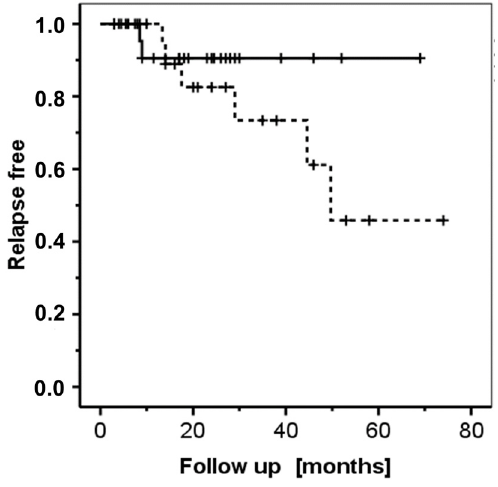
Figure 5. Relapse-free survival as a function of follow-up time (in months). Solid line: Gliptin (DPP4i)-related BP. Dashed line: non-gliptin-related BP. The short perpendicular bars represent censoring events. There is no significant difference in the times to relapse between the two patients’ groups ( p = 0.257; Log Rank Mantel-Cox test).